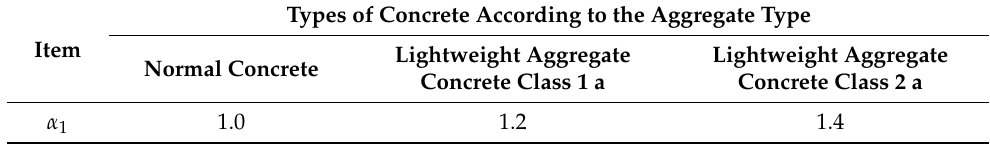
Table 4. Coefficients depending on the types of concrete according to aggregate types.